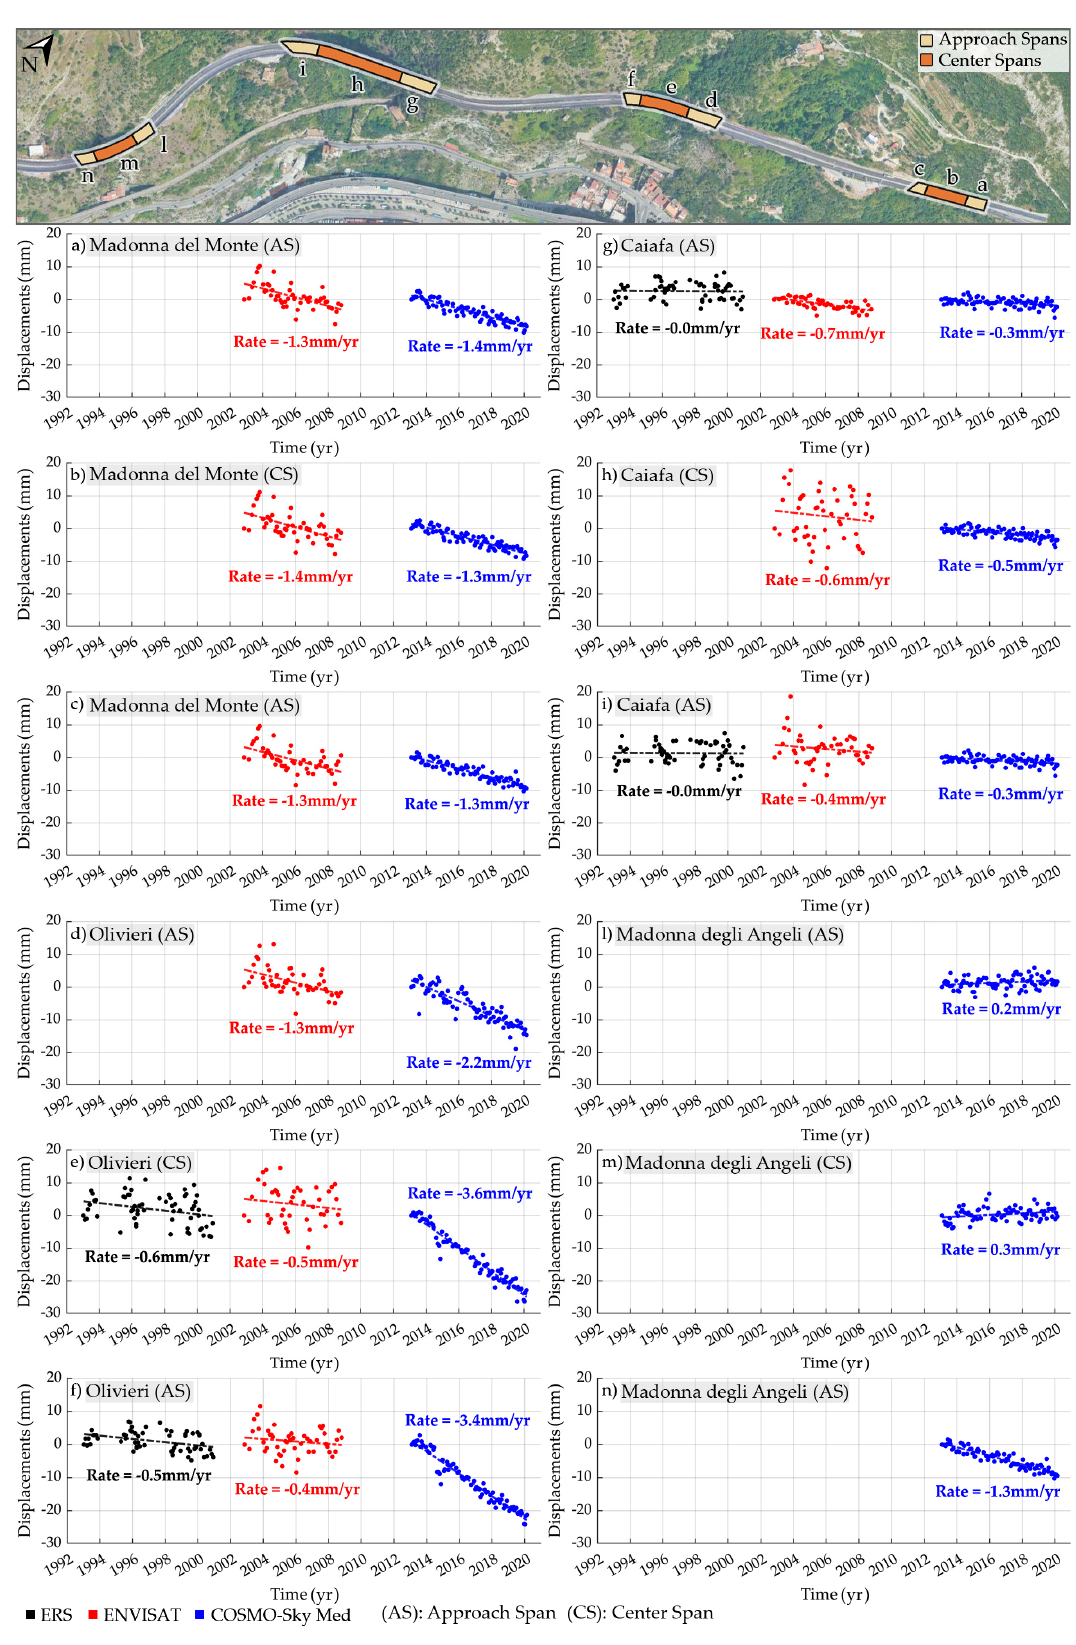
Figure 9. Time series. The time series ( a – n ) follow the travel direction along the north carriageway of the analyzed section of road.